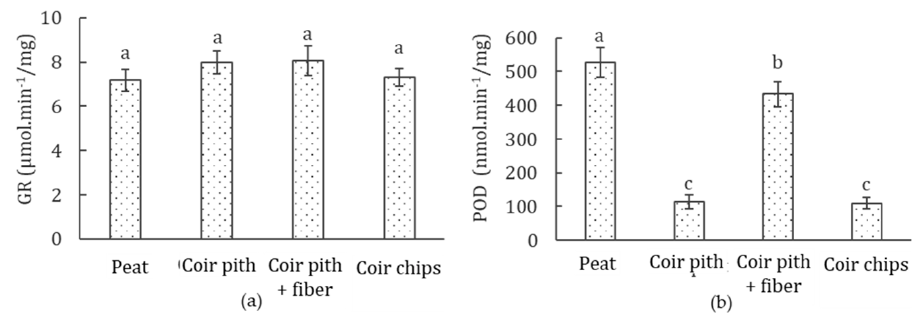
Figure 6. Glutathione reductase (GR) ( a ) activity and peroxidase (POD) ( b ) activity in the leaf blade. Means with different letters are significantly different at p < 0.05. Each bar represents the mean of five replicates, and the error bars represent ± 1SE.